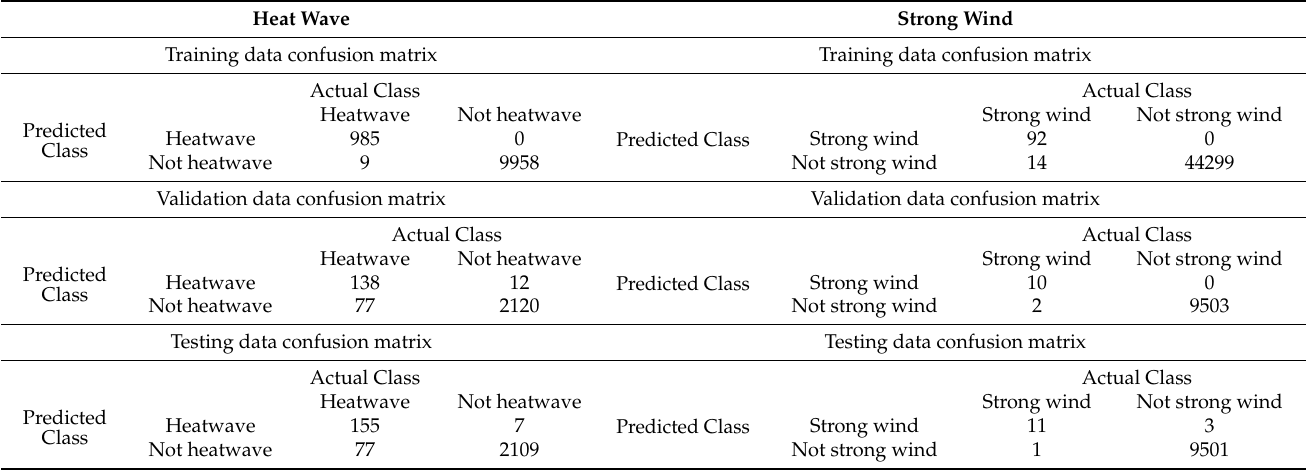
Table 2. The confusion matrix of the heatwave and strong wind models of station